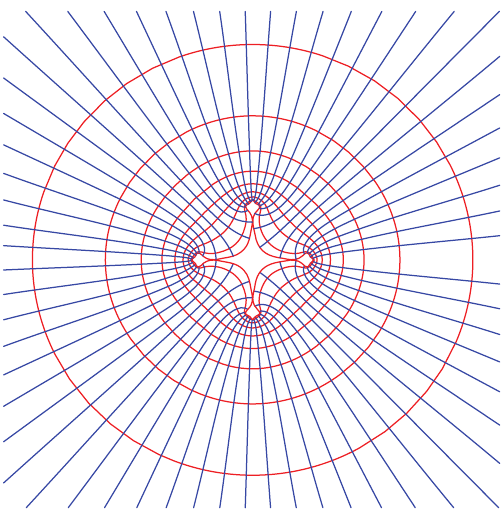
Figure 17: Exterior of a tree, Step